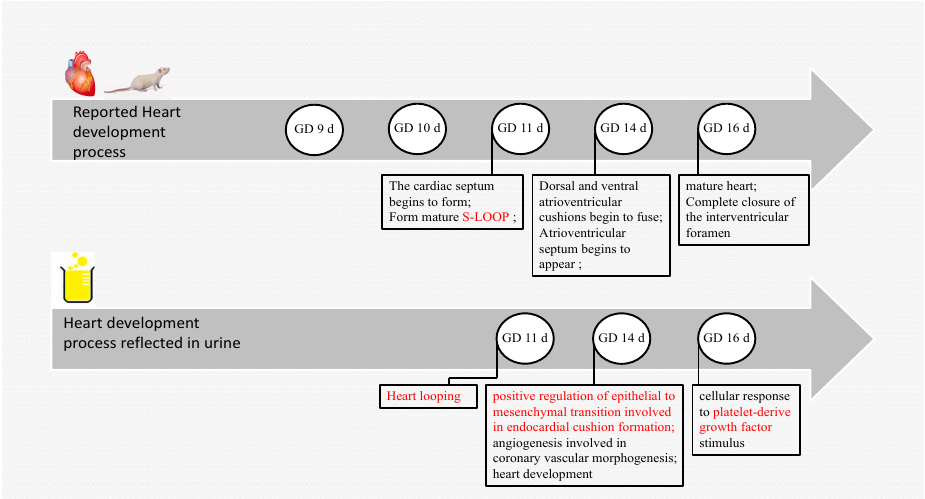
Figure 4. Fetal rat heart development. The above is the reported heart development process. The following are cardiac developmental processes enriched by changing urinary proteomes.